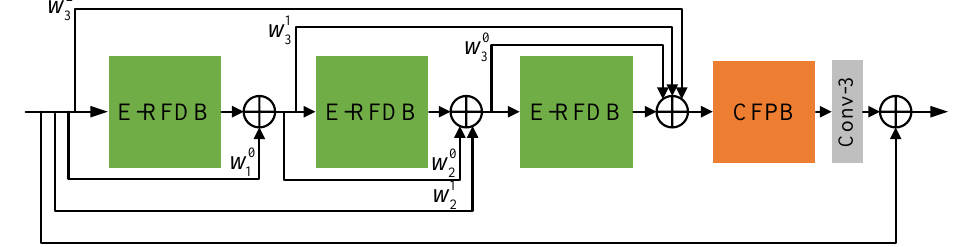
Figure 3. The feature distillation pyramid residual group (FDPRG). W j